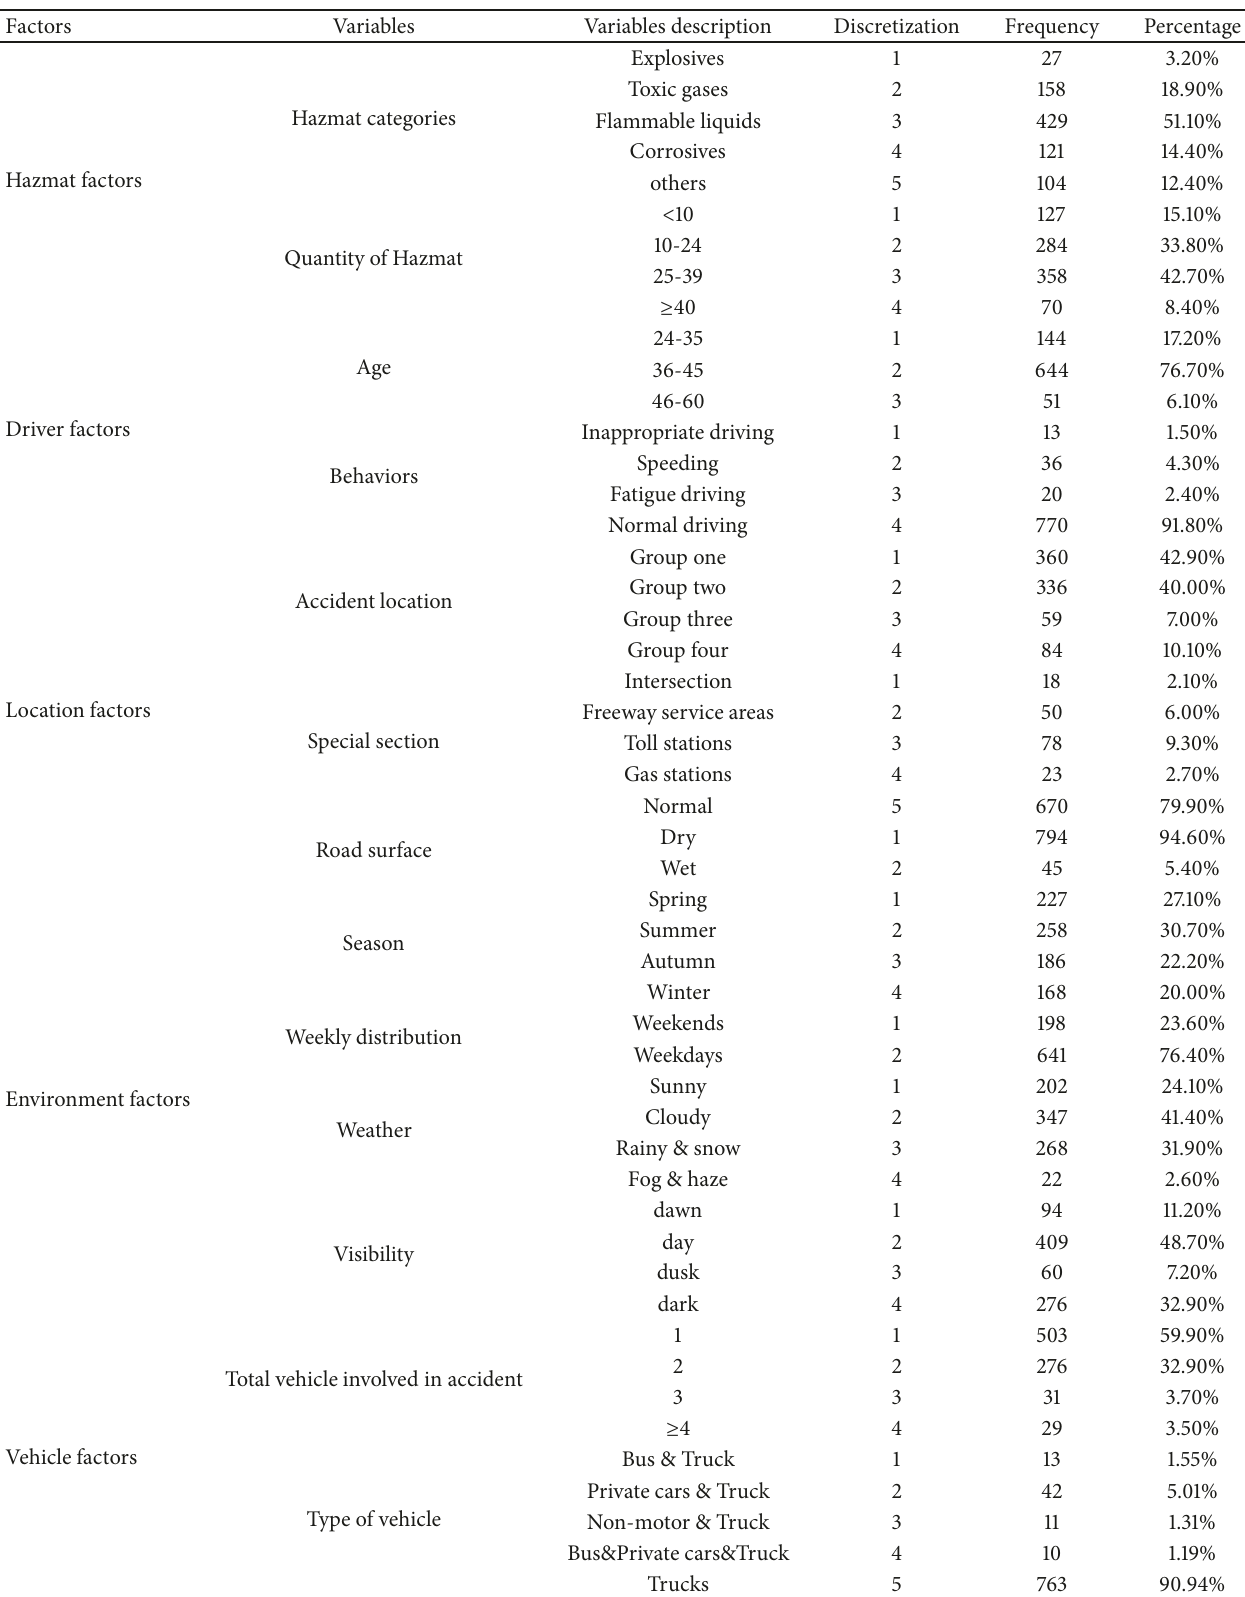
Table 1: Variables of Hazmat road transportation